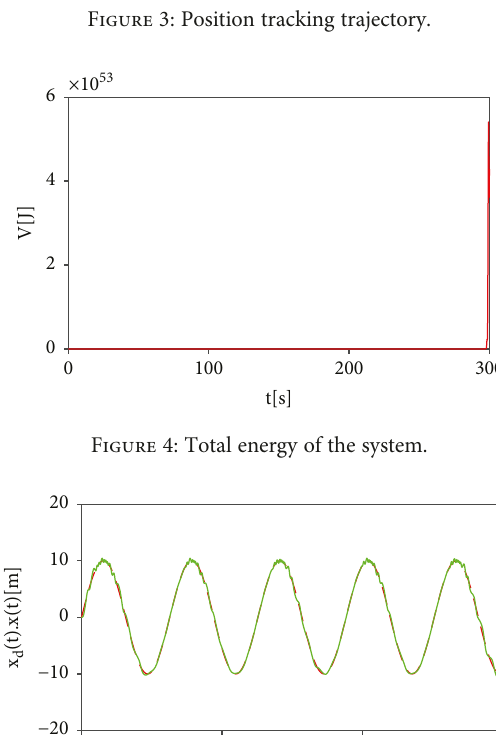
Figure 6: State of energy tank.